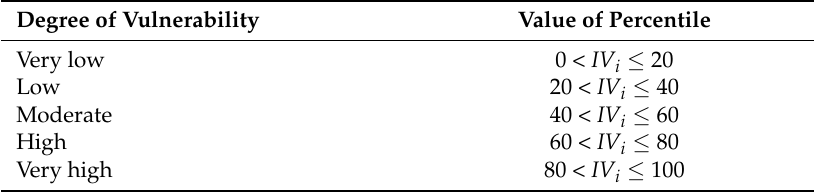
Table 8. Degree of vulnerability to drought classification